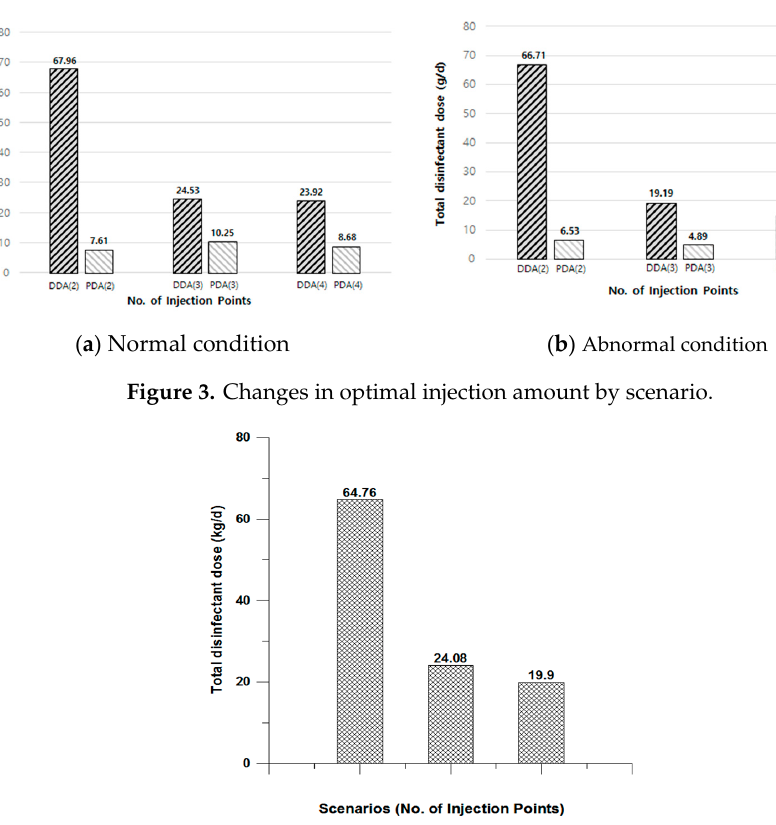
Figure 3 diagrams an optimal model operation under normal and abnormal conditions where